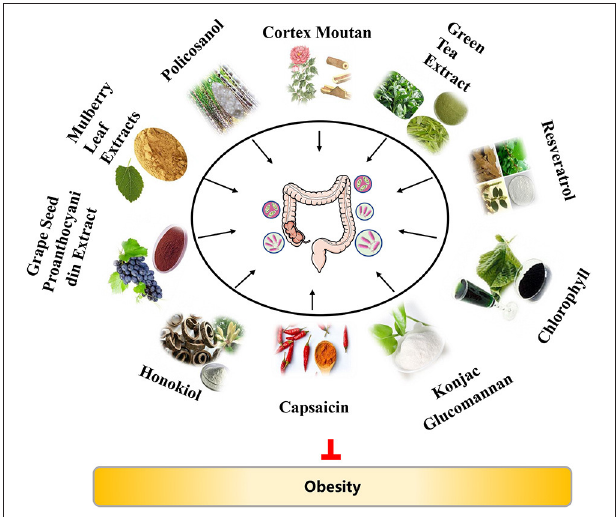
FIGURE 1 | The overview of anti-obesity effects of plant extracts via gut